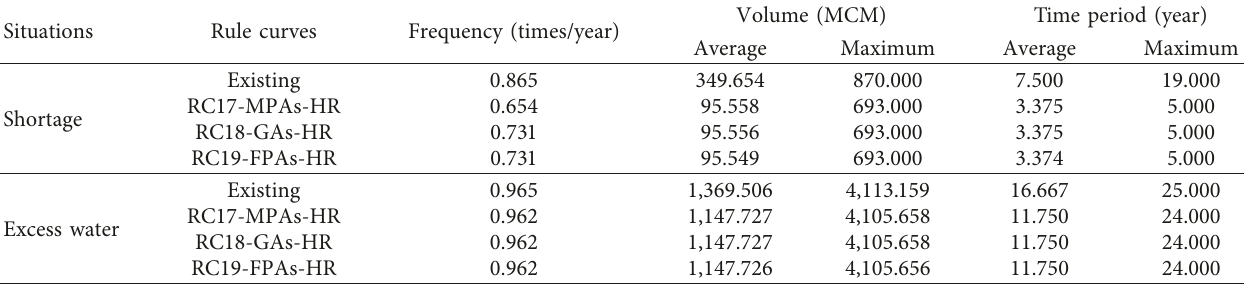
Figure 11: Optimal rule curves of the Ubolratana reservoir from MPA, GA, and FPA techniques. Table 6: The situations of water shortage and excess water of using optimal rule curves from MPA, GA, and FPA techniques considering sedimentation and HR criteria.